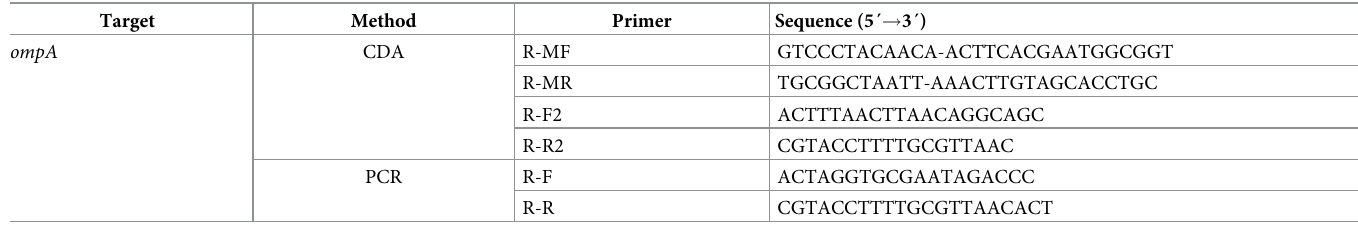
Table 2. Primer sequences of RO-CDA and PCR targeting at map gene of Rickettsia raoultii